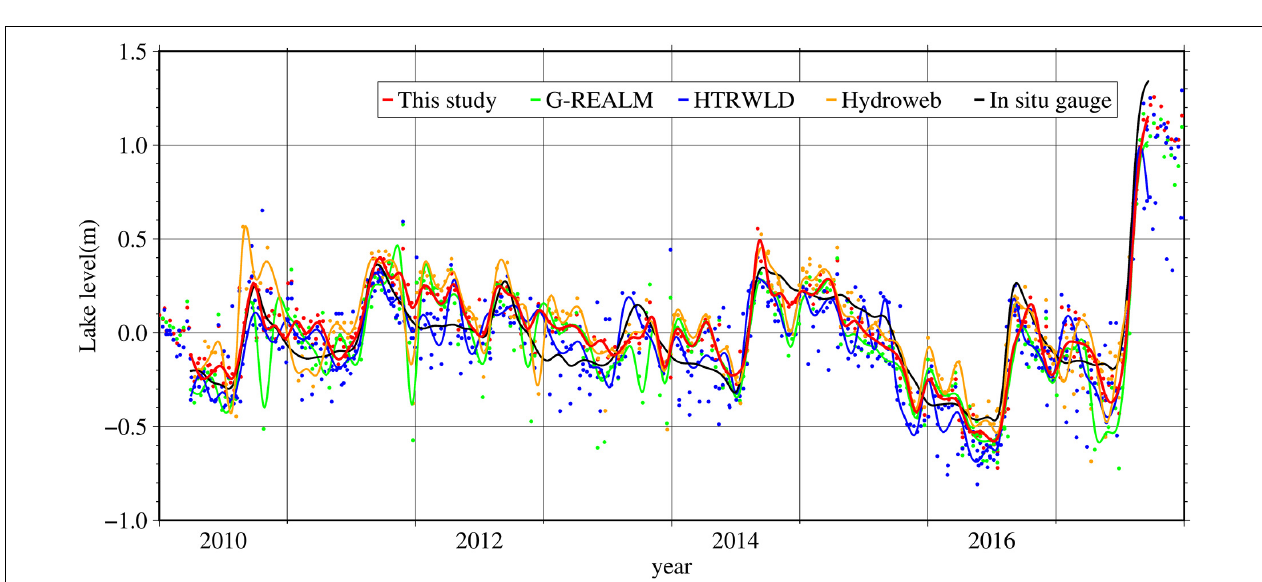
FIGURE 9 | Lake level changes of the four databases corresponding to in situ gauge data.